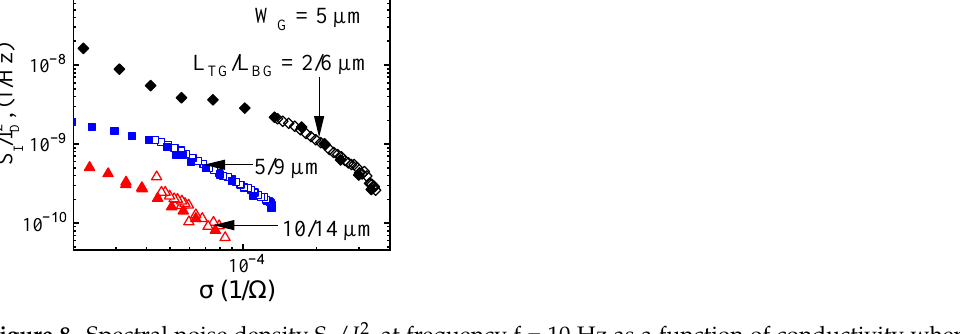
Figure 8. Spectral noise density S I / I 2 at frequency f = 10 Hz as a function of conductivity when D controlled by the top or back gate voltages for three transistors with different channel dimensions. Filled symbols correspond to the top gate voltage; open symbols are for back gate voltage.